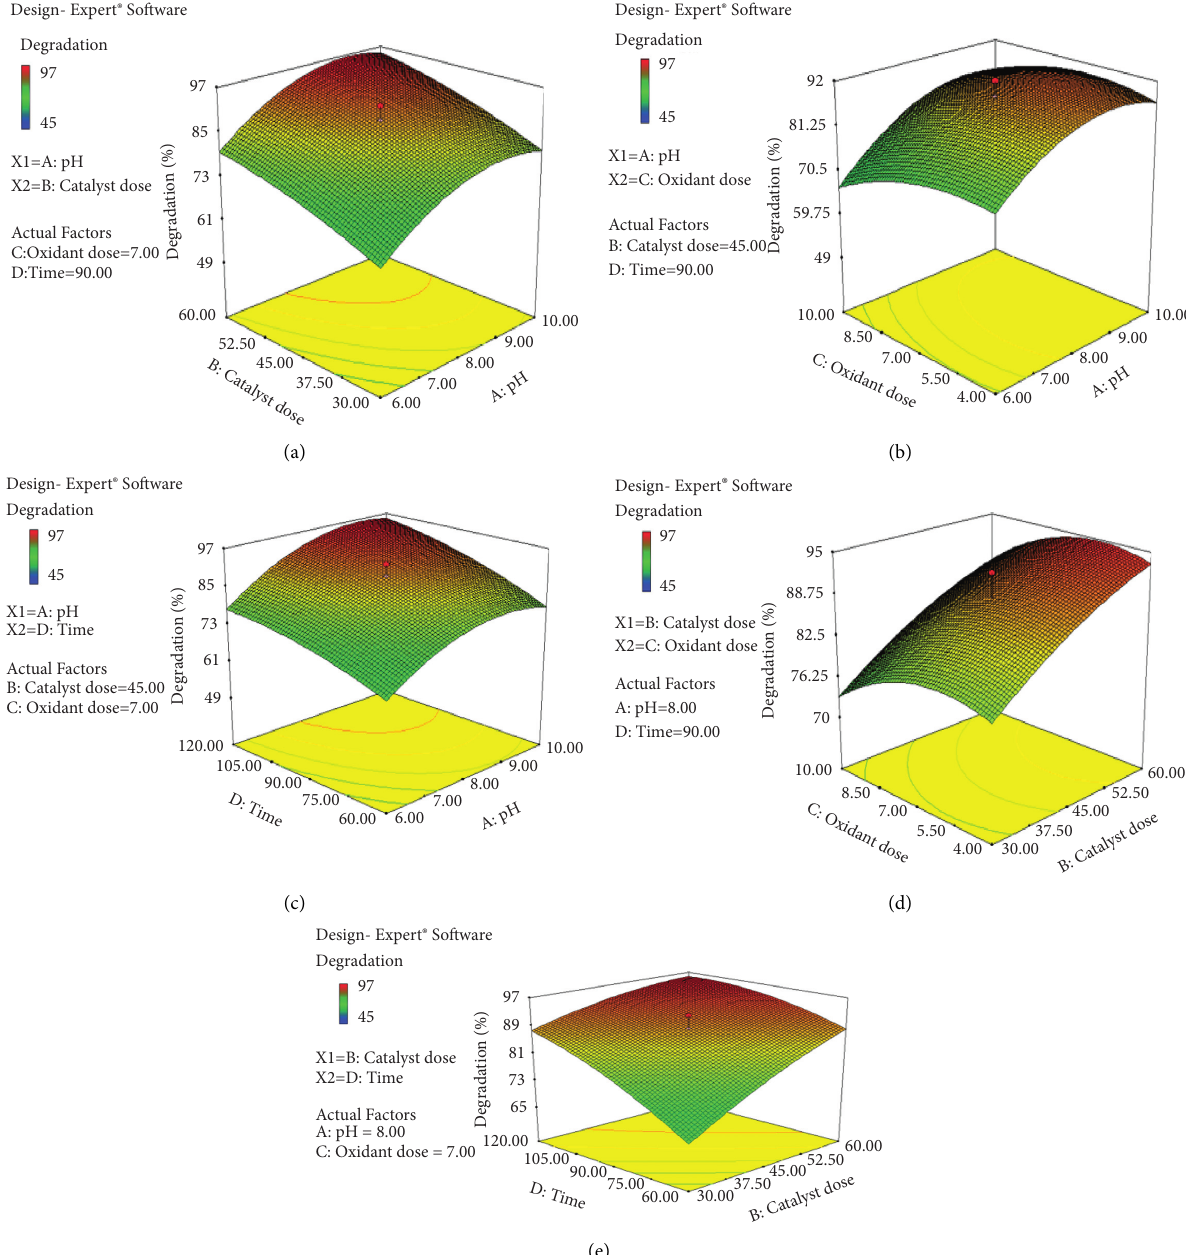
Figure 9: Response surface methodology showing the interaction of various reaction parameters. Interaction between (a) catalyst dose and pH, (b) oxidant dose and pH, (c) time and pH, (d) catalyst dose and oxidant dose, and (e) time and catalyst